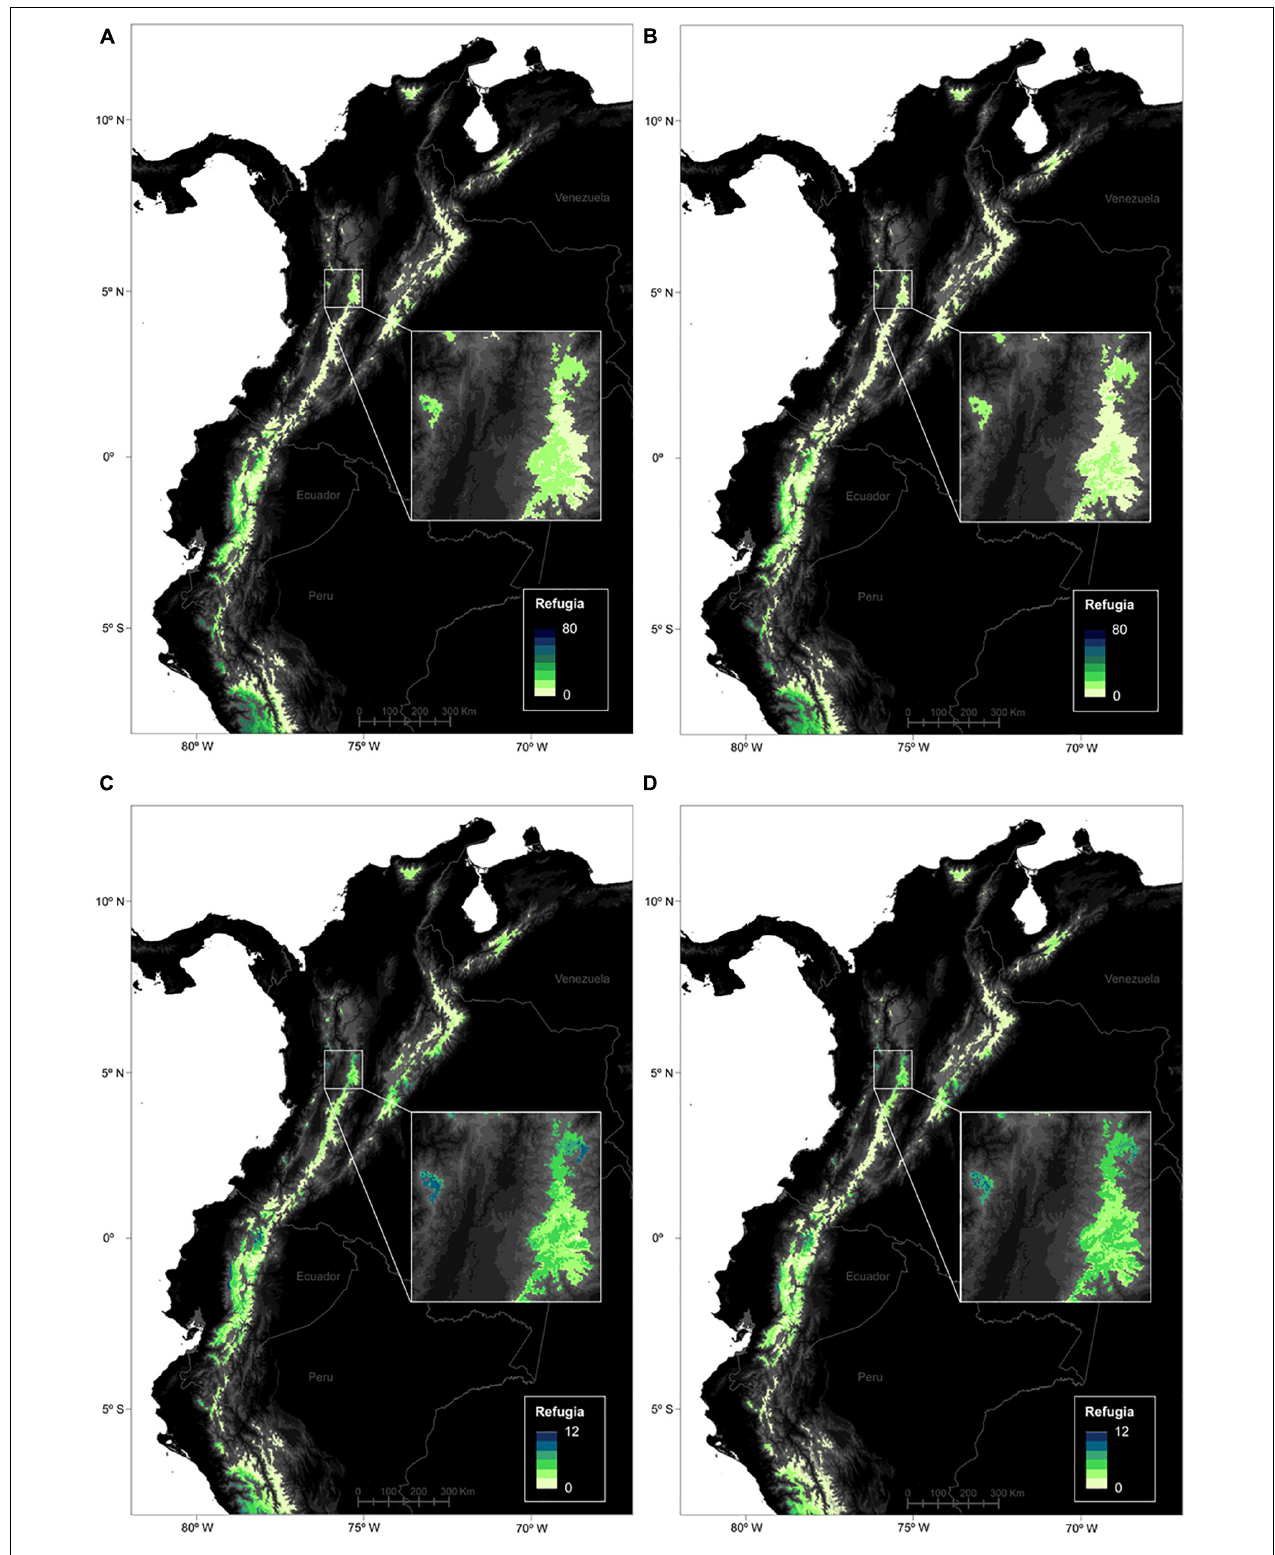
FIGURE 6 | Location of the climatic refugia for páramo plants between the Last Glacial Maximum, present time (2010) and 2070 (PPF). Refugia numbers are presented for the 664 species (max. 80) and for the average RCP45 (A) and RCP85 (B) climate change scenarios. Similarly, refugia numbers are shown for the 247 endemic species (max. 12) and for the average RCP45 (C) and RCP85 (D) climate change scenarios.